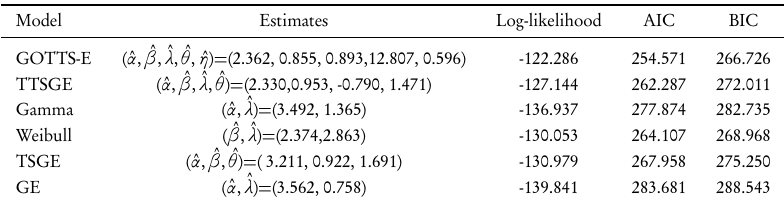
The MLE’s of parameters for the first data